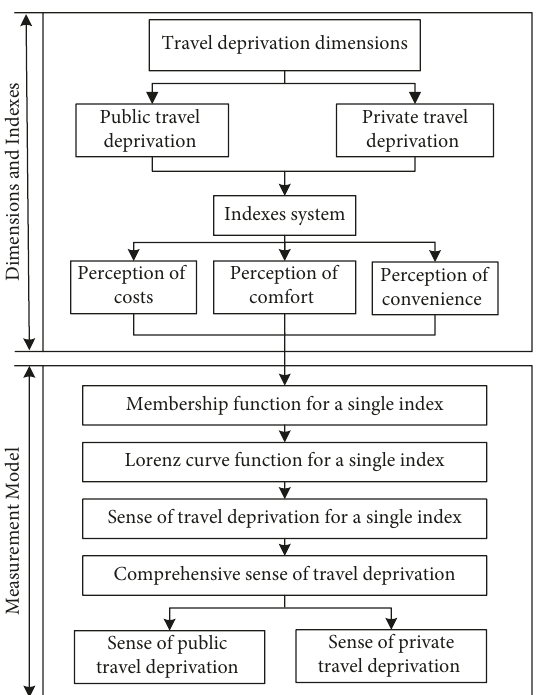
Figure 2: Flowchart used to measure the sense of travel